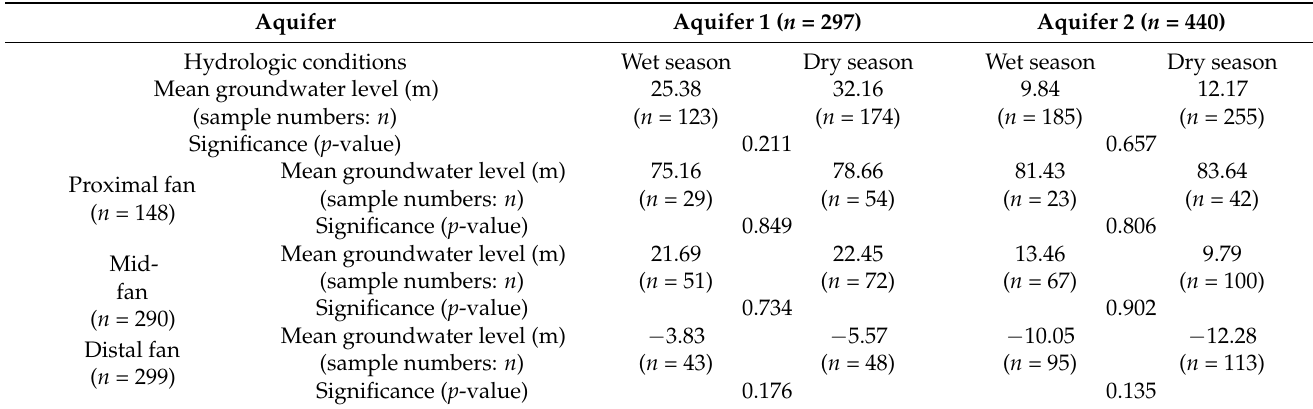
Table 2. Mean groundwater level and significance ( p -value) in the Zhuoshui River alluvial fan Aquifer 1 and Aquifer 2 between the wet and dry seasons from 2008 to